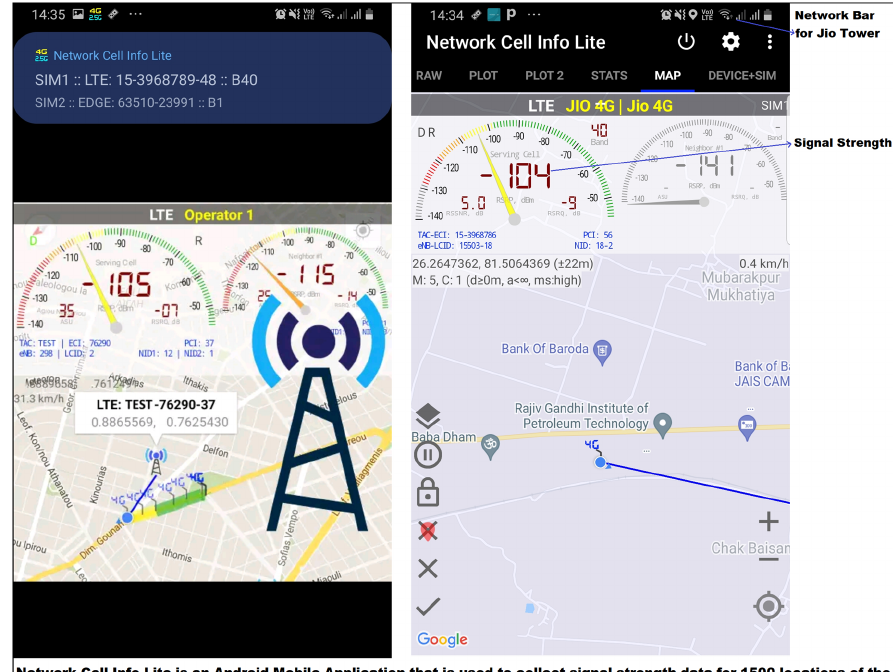
Figure 9. Mobile app for signal strength collection, Network cell info lite.